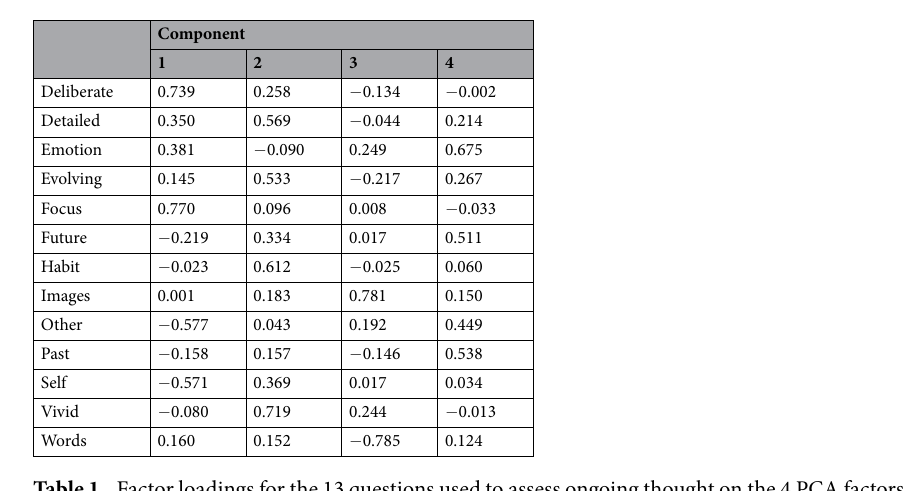
Table 1. Factor loadings for the 13 questions used to assess ongoing thought on the 4 PCA factors. Only factor 1 was used in this